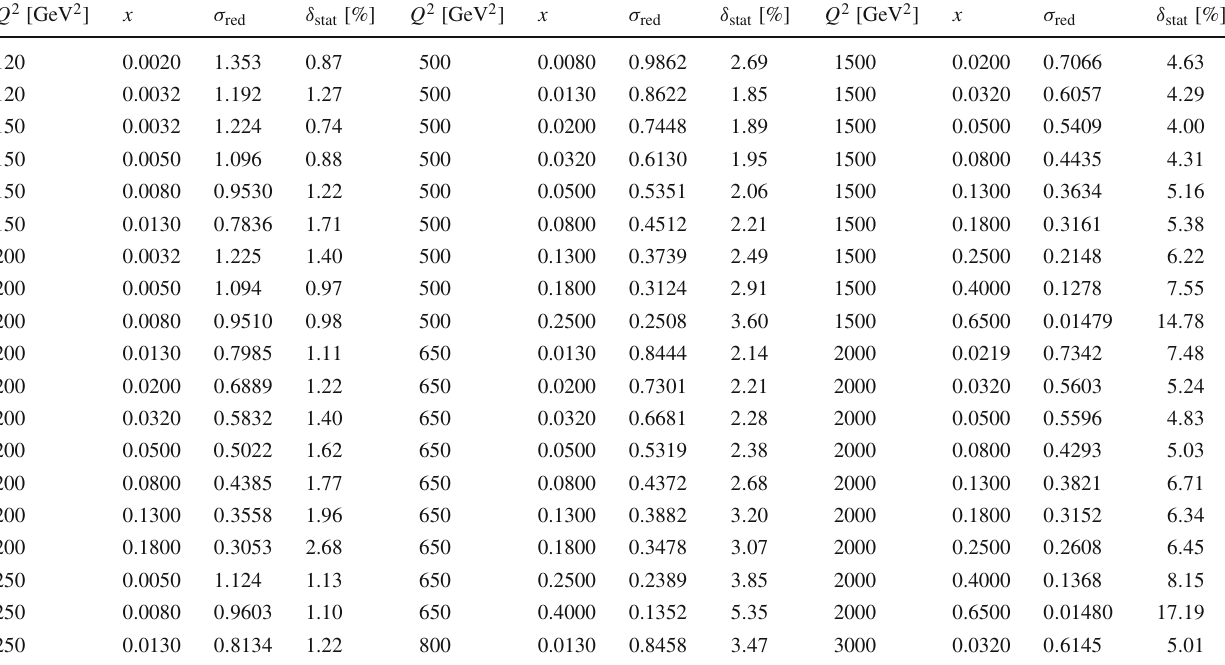
Table 9 The NC e + p reduced cross section σ red with lepton beam polarisation P e = 32 . 5% with their statistical ( δ stat ) uncertainties. The full uncertainties are available in Ref. [58], while the respective cross section values are updated according to Sect. 3 and Ref.